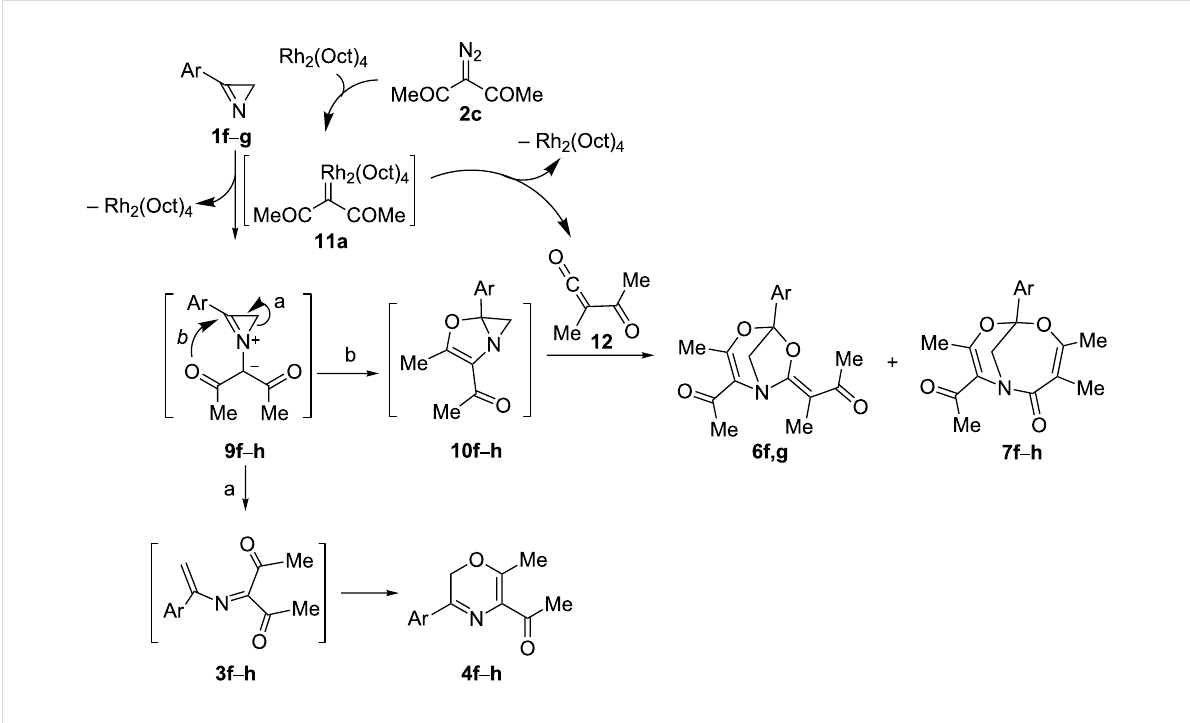
Scheme 3: General scheme for the formation of compounds 4 , 6 and 7